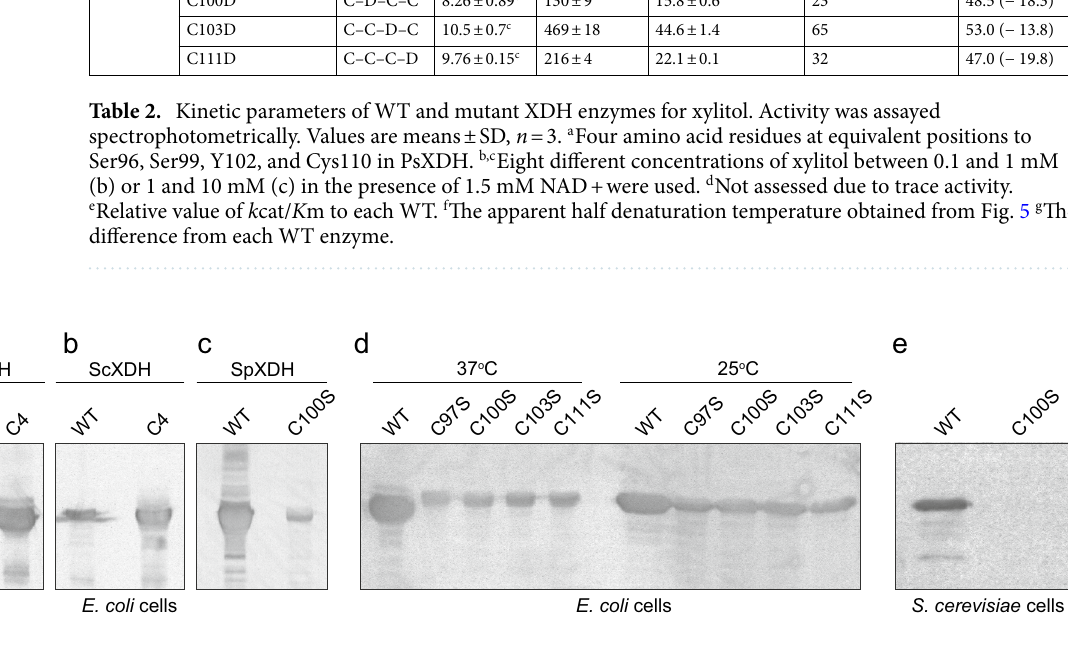
Figure 7. Intercellular expression level by an immunoblot analysis. Fifty micrograms each of cell-free extracts of transformed E. coli ( a – d ) or S. cerevisiae cells ( e ) was applied. A Western blot analysis was performed using the ECL Western blotting system (GE Healthcare) and Anti-Penta-His antibody (Qiagen) according to the manufacturer’s